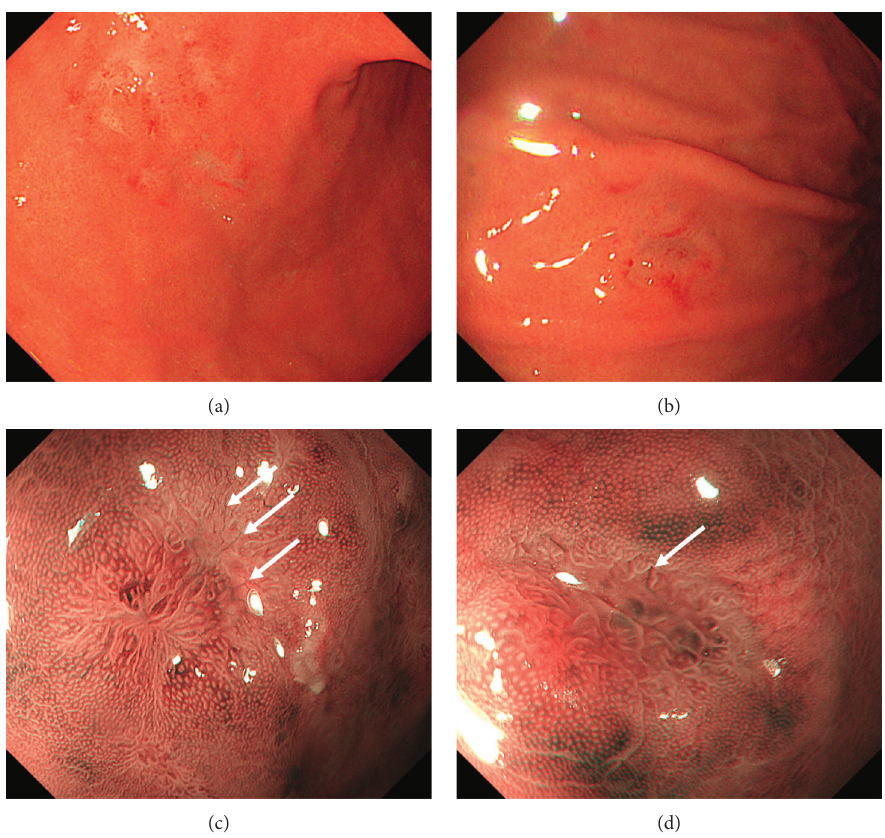
Figure 1: Esophagogastroduodenoscopy images. Multiple white irregularly shaped depressed lesions with partial redness are seen in the gastric body (a, b). Magnified narrow-band imaging images show the disappearance of the pit structure and elongated microvessels within the depressed areas (c, d, arrows). These microstructures are typical of gastric MALT lymphoma. MALT: mucosa-associated lymphoid